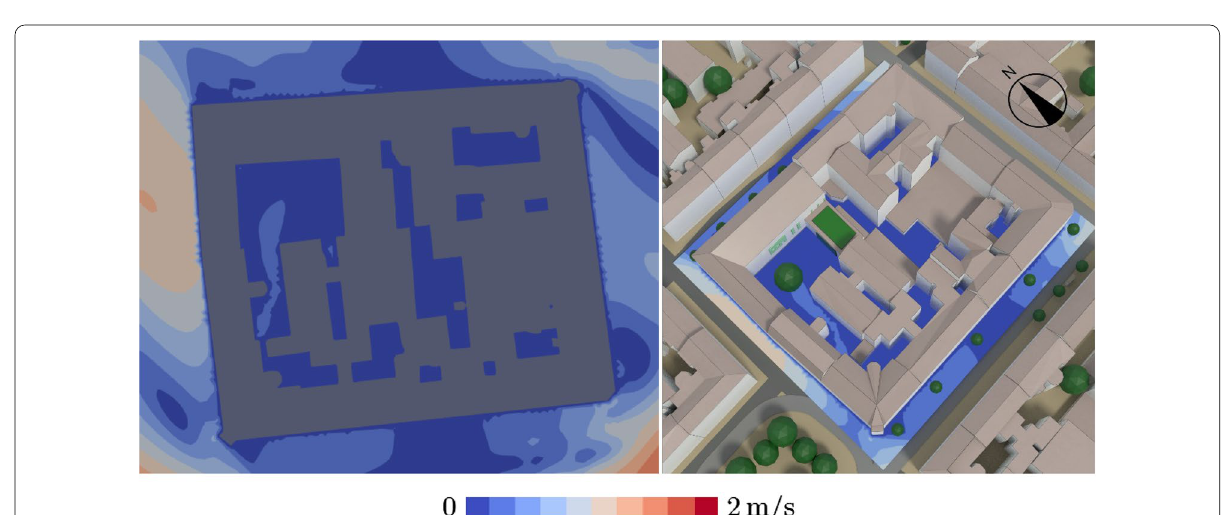
Fig. 17 Velocity of air flow of the simulation case Kandlgasse, 1.5 m above the ground at 14:00 CEST on 01 August